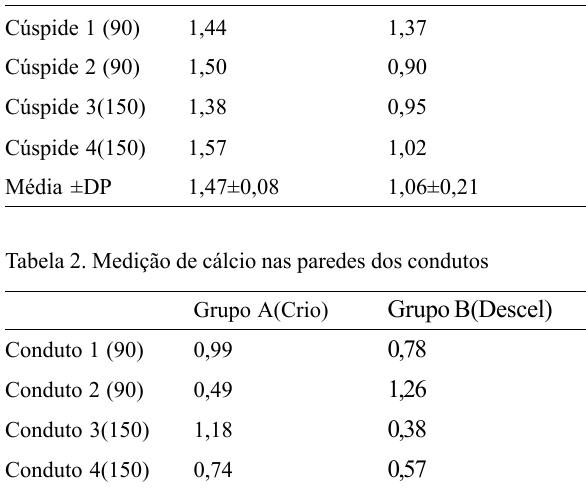
Fig. 3 - Análise histológica de homoenxerto criopreservado explantado com 5 meses de evolução. A. Fotomicrografia demonstrando cúspide valvar com perda quase completa da celularidade. Coloração HE 20X. B. Perda total dos fibroblastos, porém com camada endotelial bem preservada na região média da cúspide. C. Margem livre da cúspide demonstrando ausência de células endoteliais e discreta camada